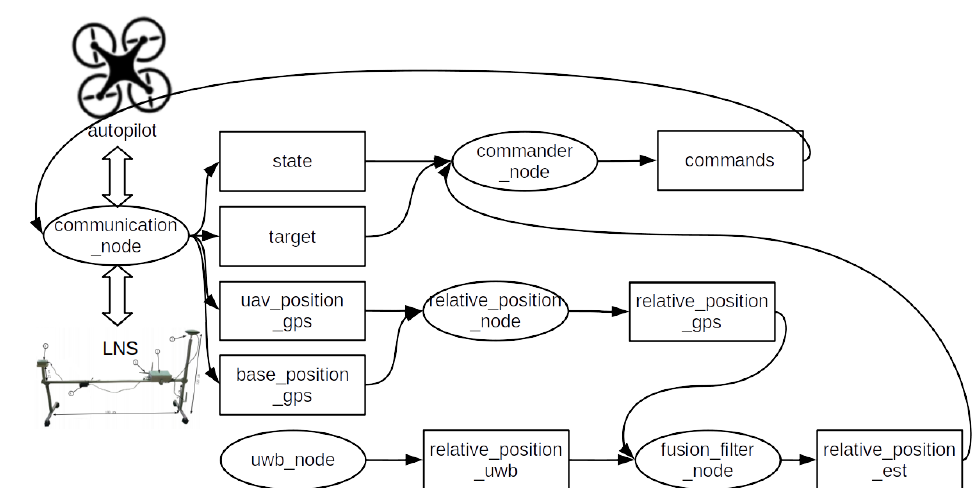
Figure 9. Diagram of the ROS-based control system for the onboard computer. ROS (robot operating system) nodes are shown as ovals and ROS topics are presented in rectangles.